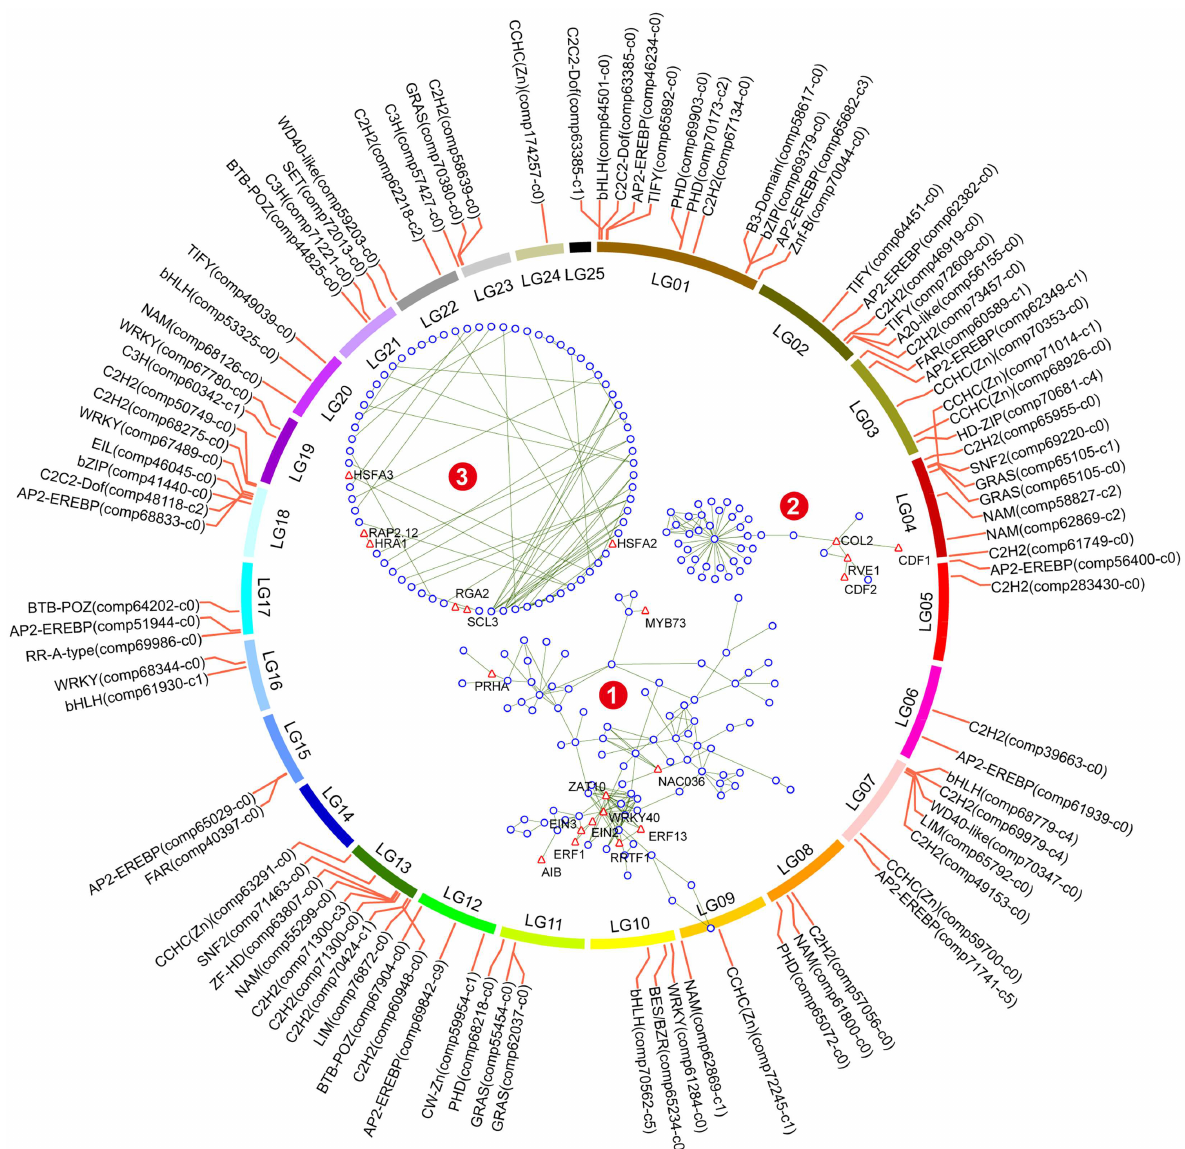
Fig 5. Distribution of cold-responsive transcription factors in pineapple ( Ananas comosus var. F153) genome and putative protein association network of CORs. The outermost circle displaysthe 25 chromosomes of pineapple. The identifiedtranscription factors in CORs are placed in their positionson the ideogram. The filtered protein associationnetwork is shown in the ideogram. Links between nodes indicate evidence of association between the two nodes in the String database with scores higher than 700. Transcription factors are shown as a triangle labeledwith the gene